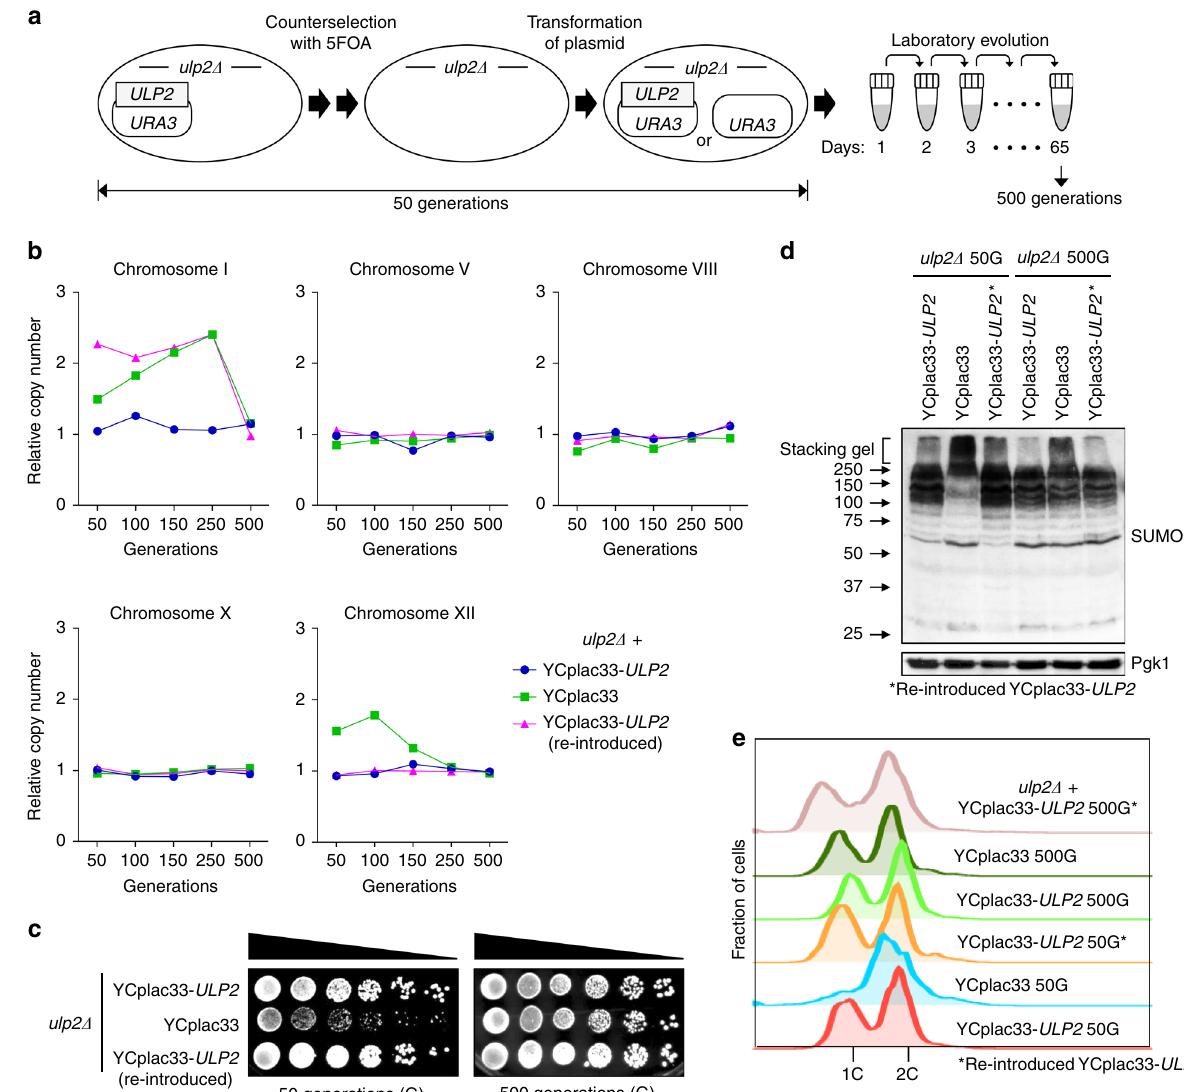
Fig. 1 Aneuploidy of ulp2 Δ cells can be reversed by laboratory evolution. a Scheme for creation of nascent ulp2 Δ cells and their subsequent passaging. The ulp2 Δ cells containing YCplac33- ULP2 were streaked on SD + FOA plates twice sequentially to evict the YCplac33- ULP2 plasmid, and they were then transformed either with YCplac33- ULP2 or YCplac33. Cells grew for ~50 generations (50 G) during these procedures. For long-term passaging, cells were grown until saturation and then diluted 1:120 in fresh YPD (6.9 generations per dilution). This process was repeated daily. b Chromosome copy number of ulp2 Δ cells with the indicated plasmids was monitored by qPCR assay at the indicated number of generations. Copy number was determined relative to WT (MHY500 + YCplac33) cells. Chromosome copy number between 50 and 250 generations were monitored previously 18 , and the data are included here. c Growth of the indicated ulp2 Δ strains at 50G and 500G. After spotting cells in fi vefold serial dilutions, the YPD plates were incubated for 2 days at 30 °C. d Immunoblot analysis of sumoylated proteins in extracts prepared from the strains in c . Anti-Pgk1 blotting was used to verify the equal loading. Asterisks indicate reintroduced YCplac33- ULP2 . The stacking gel (bracket) and molecular size standards are indicated. e Flow cytometry of DNA content of the strains from c . 1C and 2C indicate unreplicated DNA (haploid) and replicated DNA (diploid),